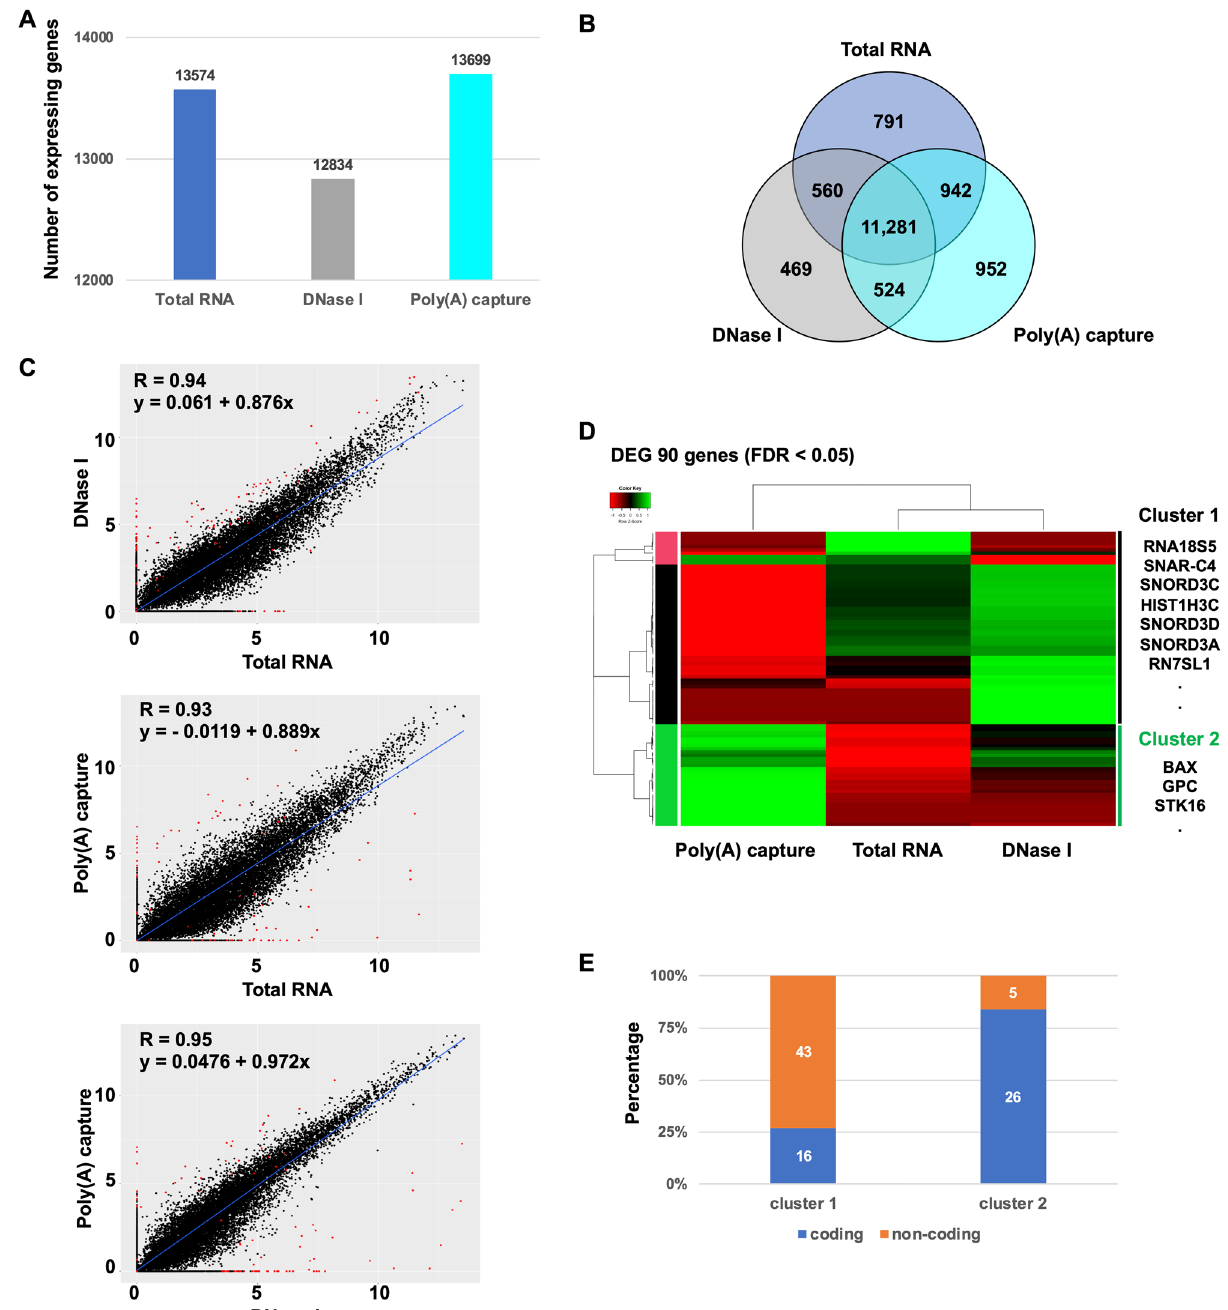
Figure 4. Comparison between Total RNA, DNase I-treated, and Poly(A) capture sequencing for quantification analysis. ( A ) The total number of expressed genes identified by these three methods. ( B ) Venn graph of expressed genes. ( C ) Scatter plot (log2 TPM (Transcripts per million)) of comparing each two methods. ( D ) Heat map of hierarchical clustering between total RNA, DNase I-treated, and Poly(A) capture sequencings. ( E ) The percentage of coding and non-coding genes in cluster 1 and